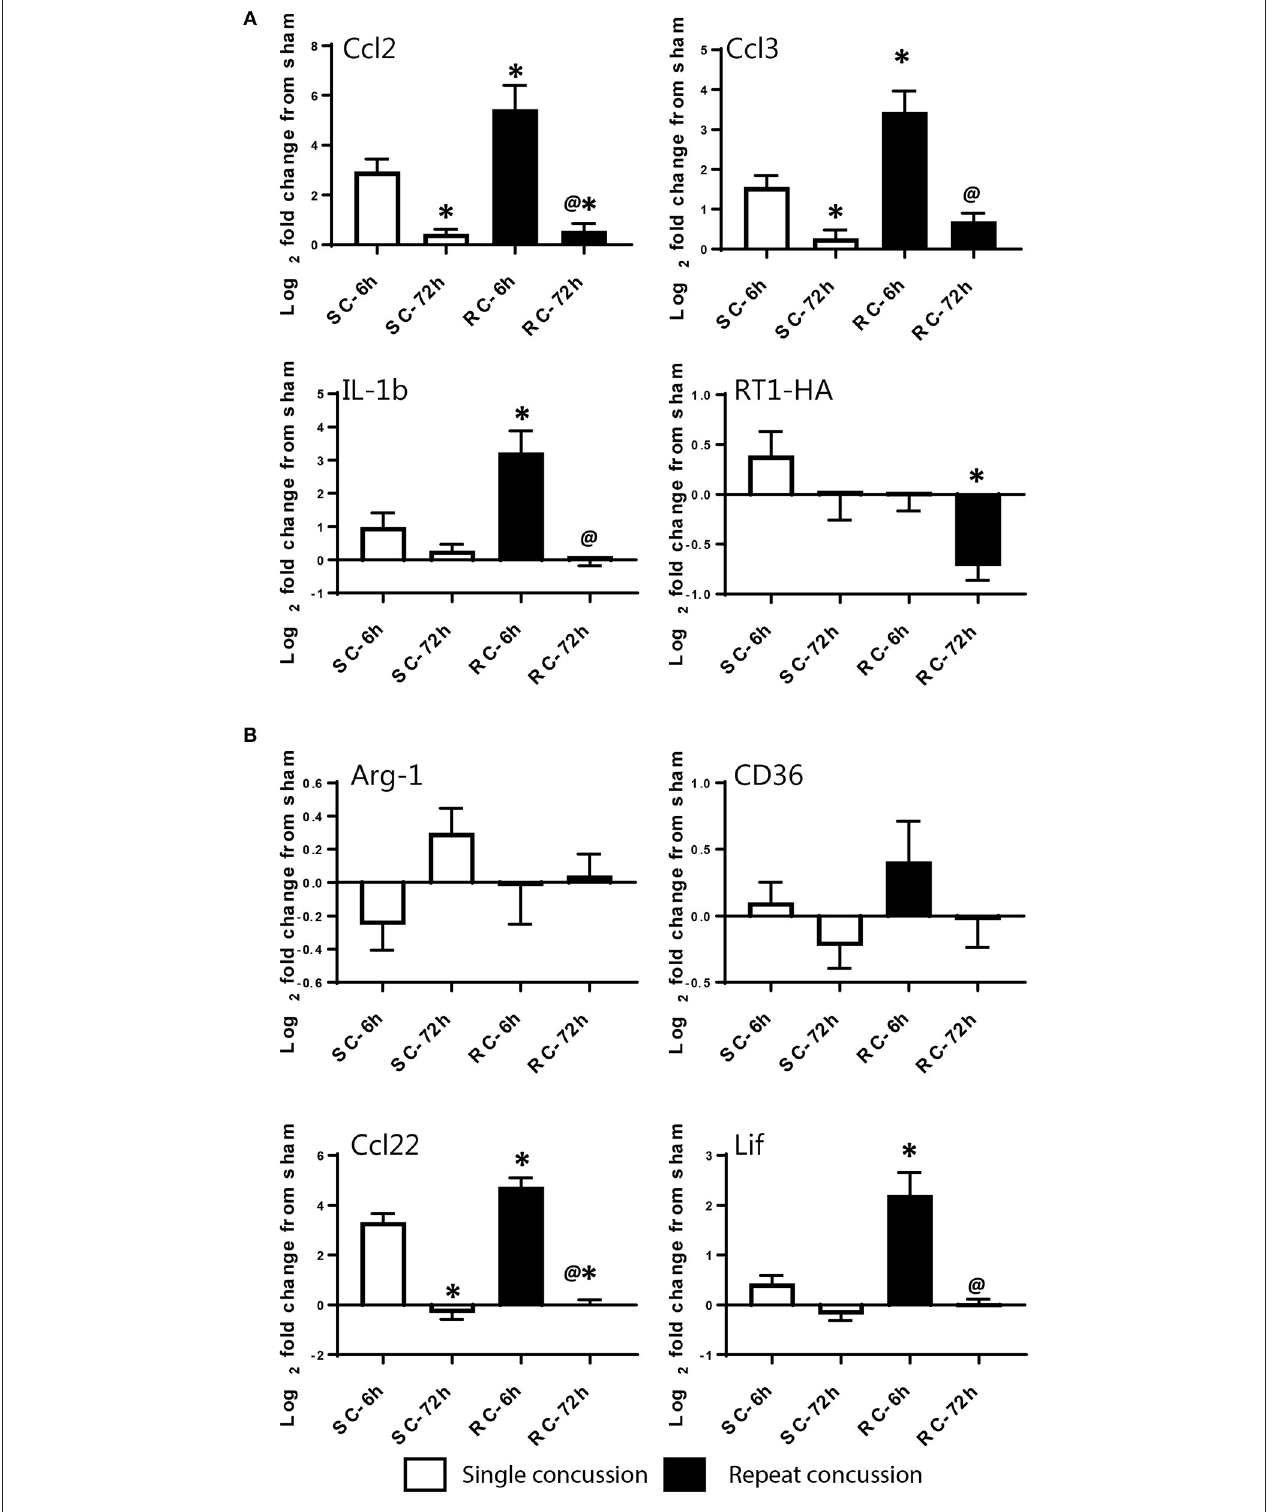
FIGURE 7 | Single gene qRT-PCR of selected targets in the ipsilateral hippocampus. Selected gene targets including both (A) M-1 and (B) M-2 markers are run separately using individual samples ( n = 10/condition). RT-1HA was included as this is part of MHC-II complex. One-way ANOVA with Tukey’s post-hoc test. * p < 0.05 compared to single hit 6h. @ p < 0.05 compared to repeated hit 6h. SC: single concussion, RC: repeated concussion, HP: hippocampus.